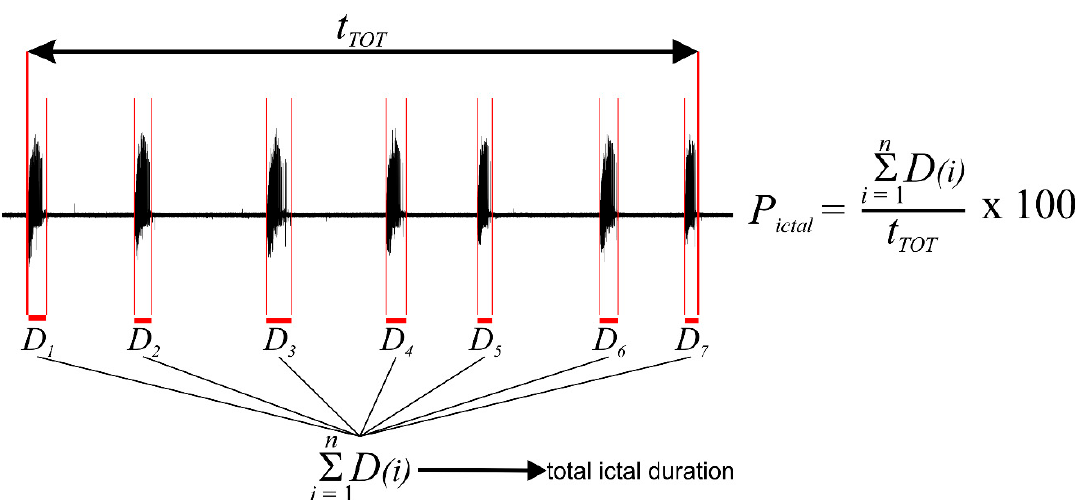
Figure A2. Seizure detection algorithm workflow. The color-coded blocks indicate the routines used for the extraction of the baseline parameters ( yellow ), the wavelet-based seizure detection ( red ), and the wavelet decomposition shared by the two ( violet ).